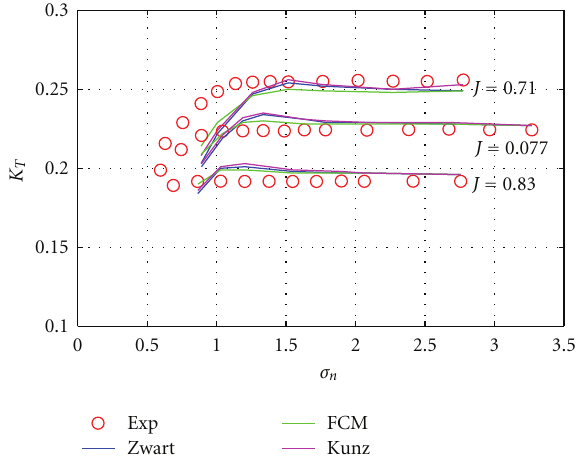
Figure 12: Influence of the cavitation number on the thrust coe ffi cient for the E779A propeller.